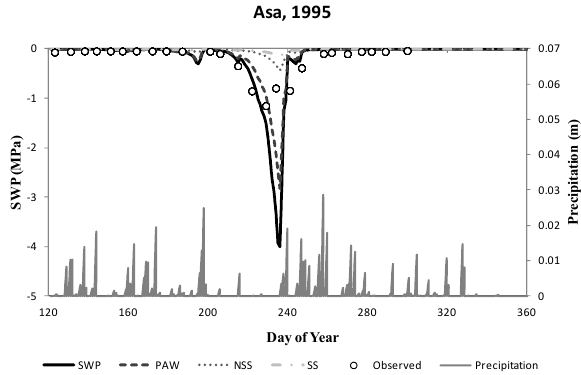
Fig. 6. Comparison of observed and modelled soil water potential (SWP) in 1995 for a Norway spruce stand at Asa using four methods that relate soil water to g sto (see methods section for details). f06